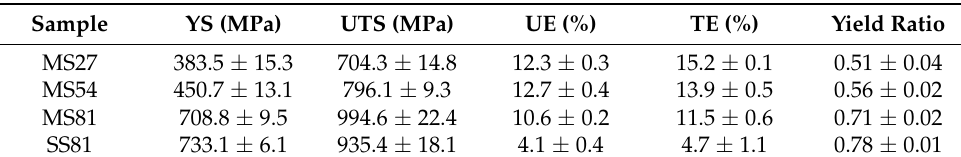
Figure 4. Ferrite grain size and volume fraction of martensite in MS27, MS54, MS81, and SS81.